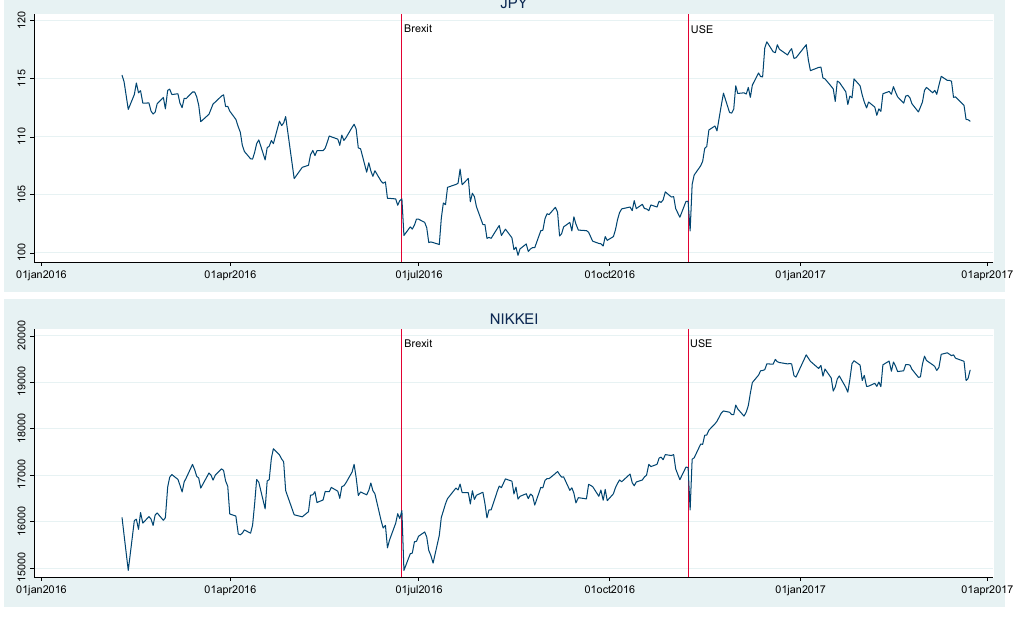
Figure 1. Daily JPY exchange rate and Nikkei closing price index.